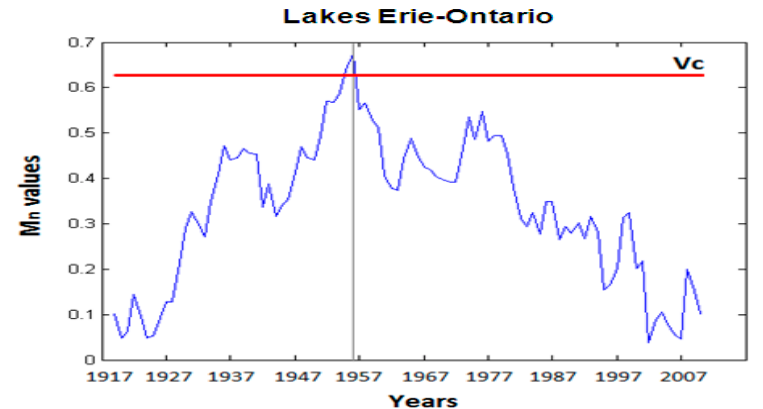
Figure 8. Analysis of dependence using the copula method. Temporal variability of M n values derived for monthly mean minimum water level series for Lakes Erie and Ontario (1918–2012). The horizontal red line shows the critical value of V c . The vertical line represents the timing of the change of dependence between the water levels.